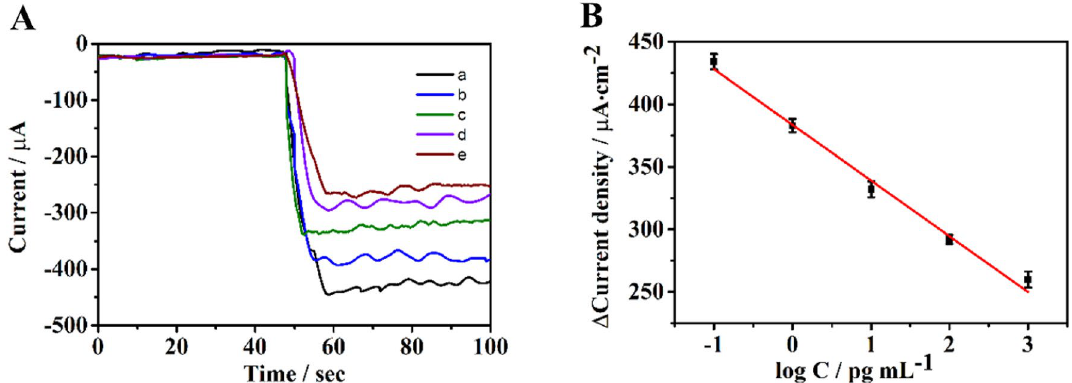
Figure 5. ( A ) The i-t response for the determination of different concentration of SPOP: (a) 0.1 pg mL −1 ; (b)